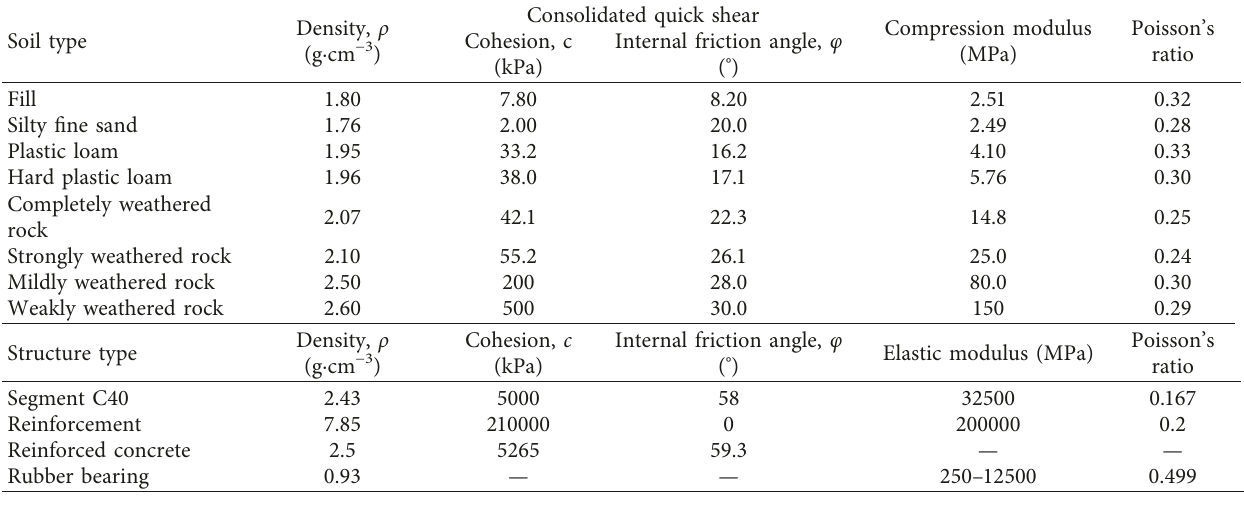
Table 1: The physicomechanical parameters of the soil and the structure.